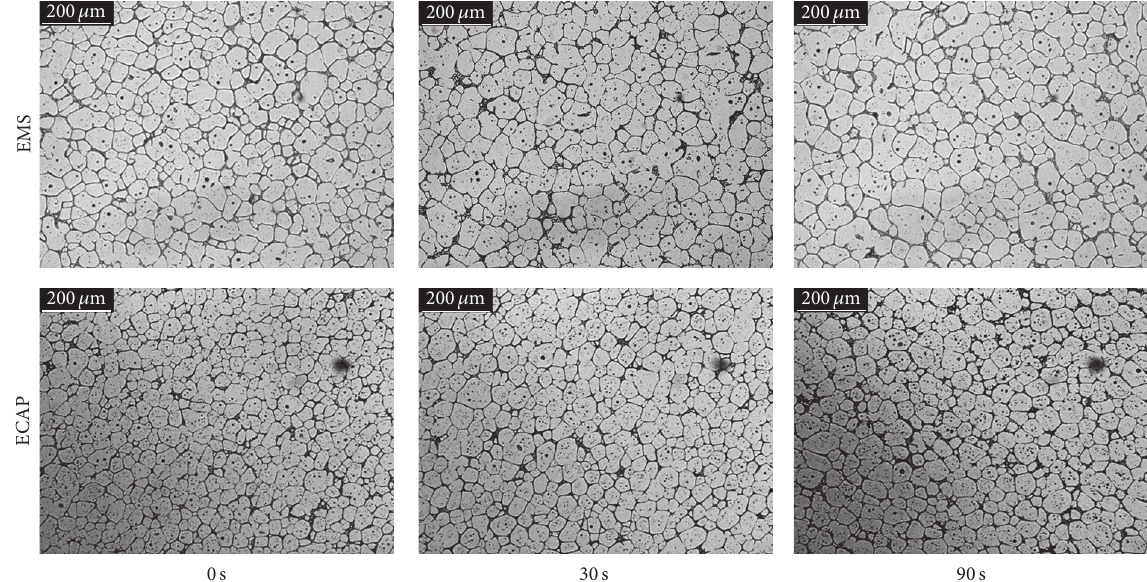
Figure 4: Conventional B&W metallography of the EMS and ECAP samples heat treated at 584 ∘ C in which is expected to be 60% of solid fraction during 0, 30, and 90 s holding time, showing the morphology of the